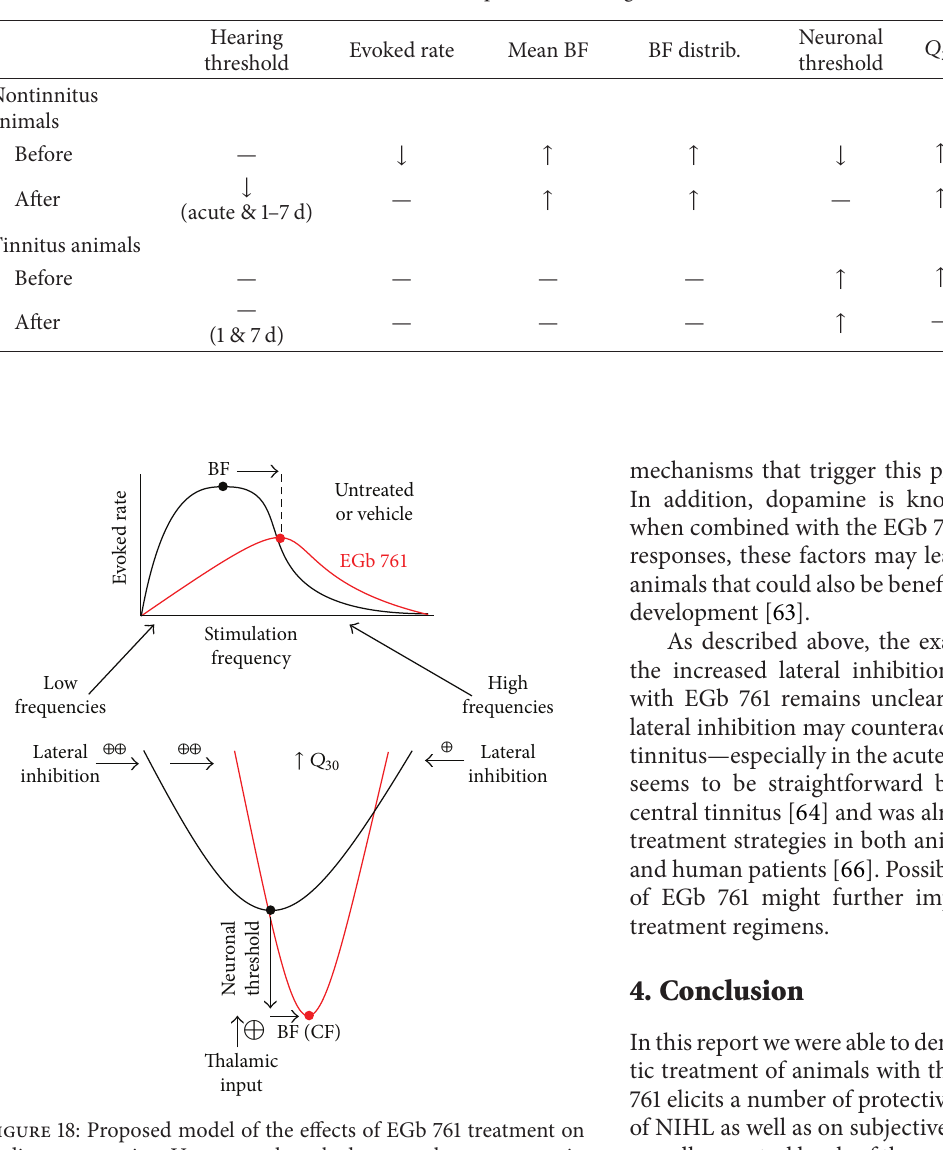
Table 1: Overview of parameter change EGb 761 versus vehicle control.